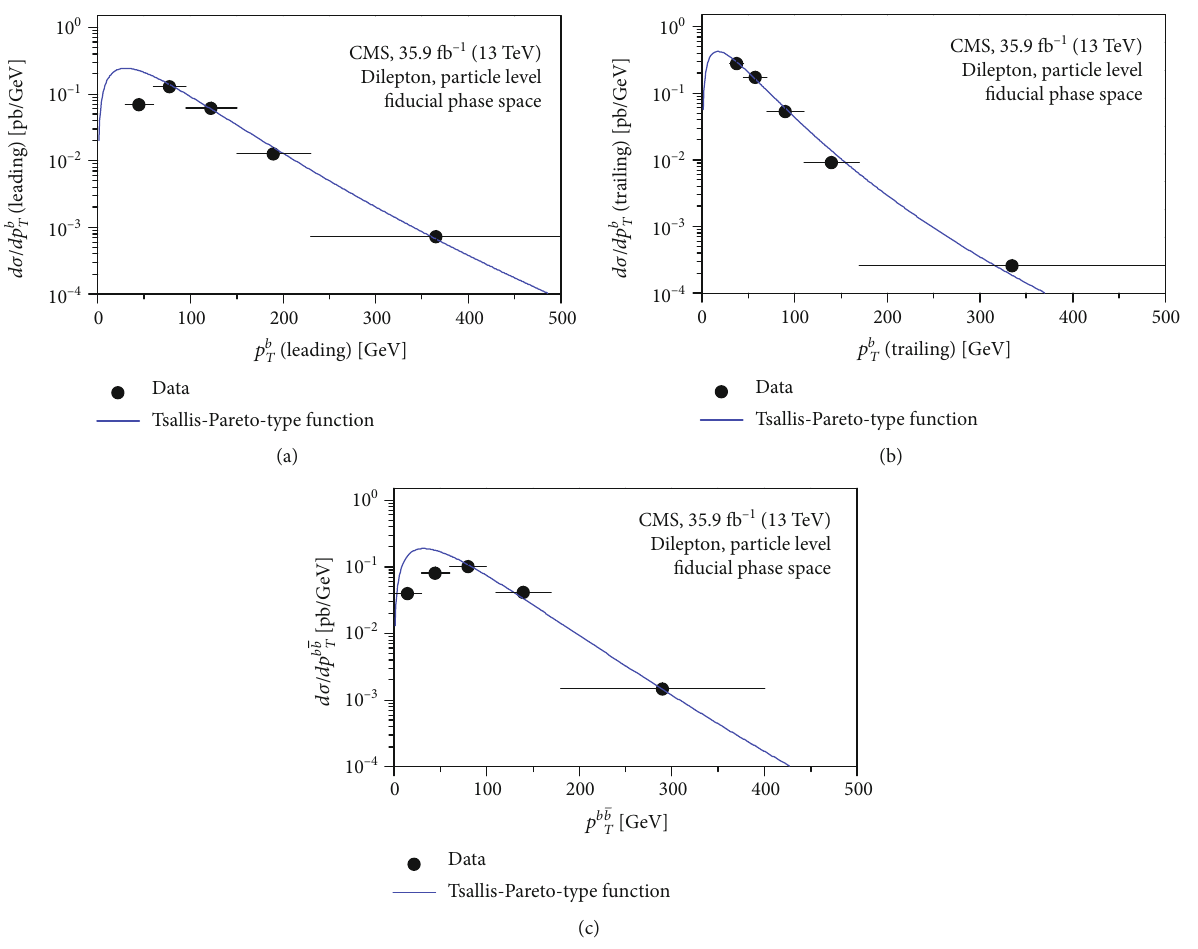
p b T ( T (leading)), fi ducial phase space.